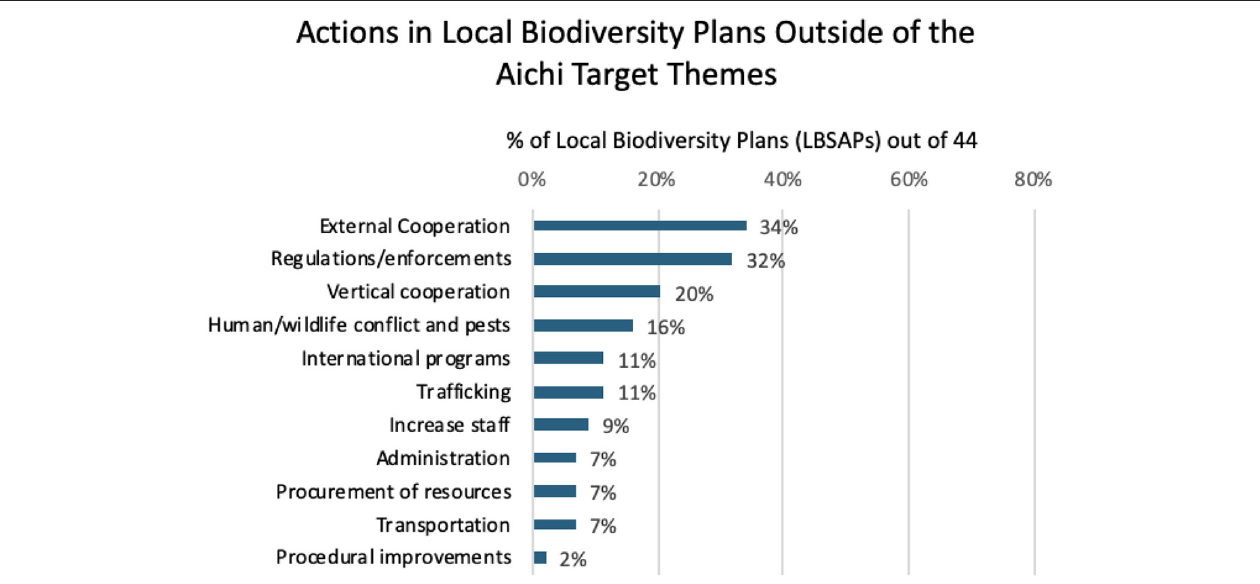
FIGURE 2 | Prevalence of other topics outside of the Aichi Biodiversity Target (AT) themes in local biodiversity